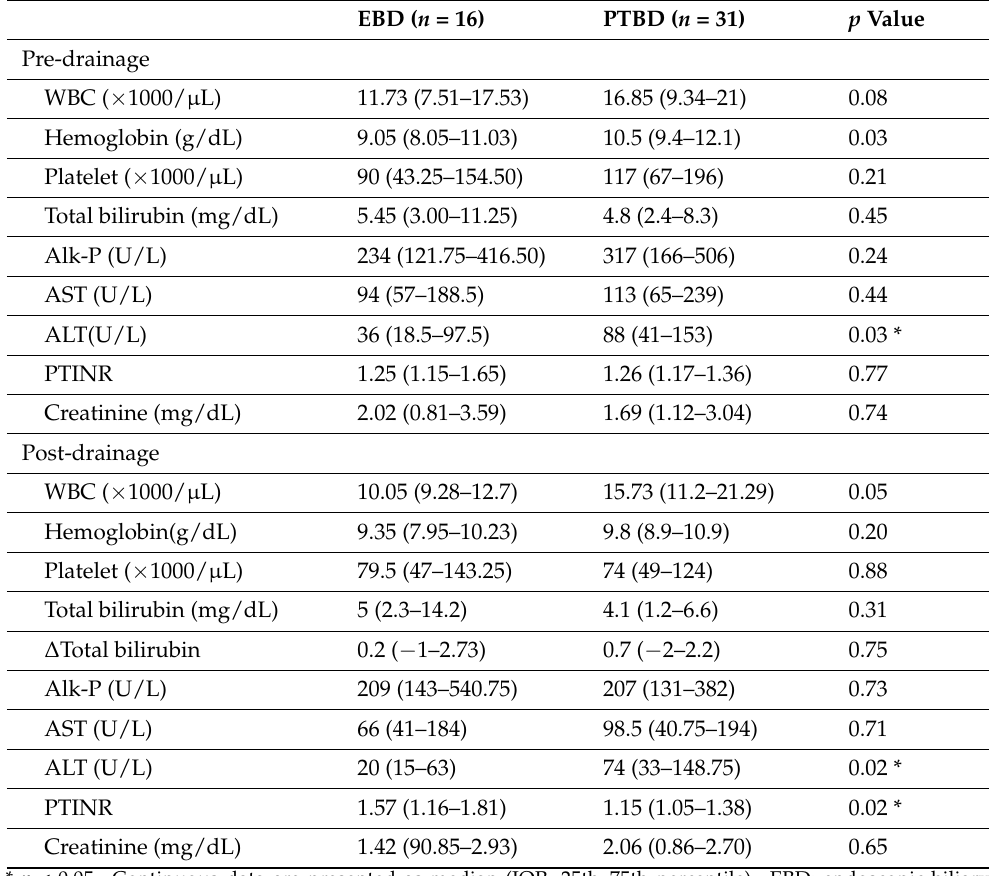
Table 2. Clinical data before and after biliary